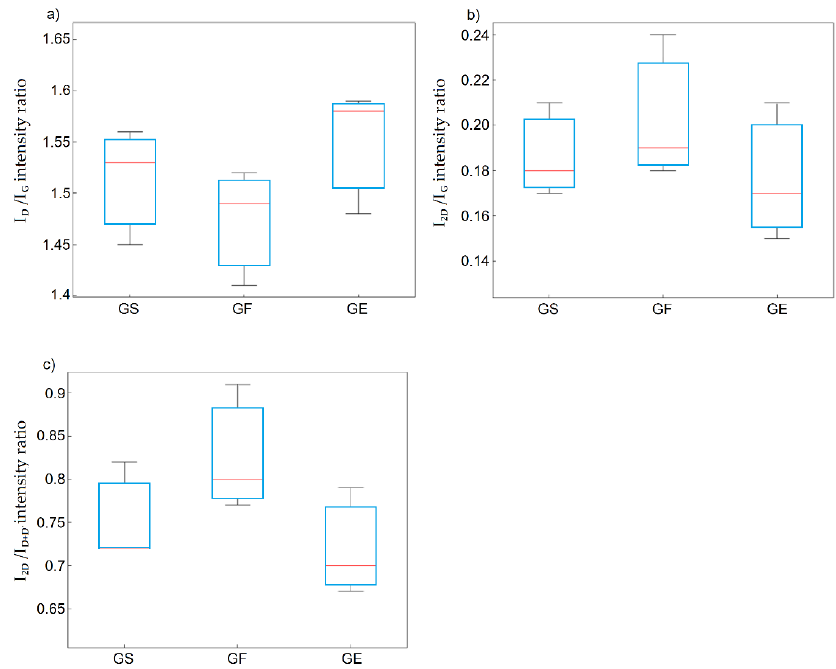
Figure 7. Box plots of: ( a ) I D /I G ; ( b ) I 2D /I G ; ( c ) I 2D /I D+D’ ratio as a function of the precursor material. The graphites oxidized using methods A, B, and D were selected to prepare reduced graphene oxides. The obtained graphene materials were characterized by 2–3-fold lower oxygen content than those for the corresponding graphite oxides. These differences were clearly visible when the collected data were analyzed using HCA. Figure 8 shows green dendrograms, which describe samples of reduced graphene oxides and variables characterizing the degree of oxidation of the investigated materials.